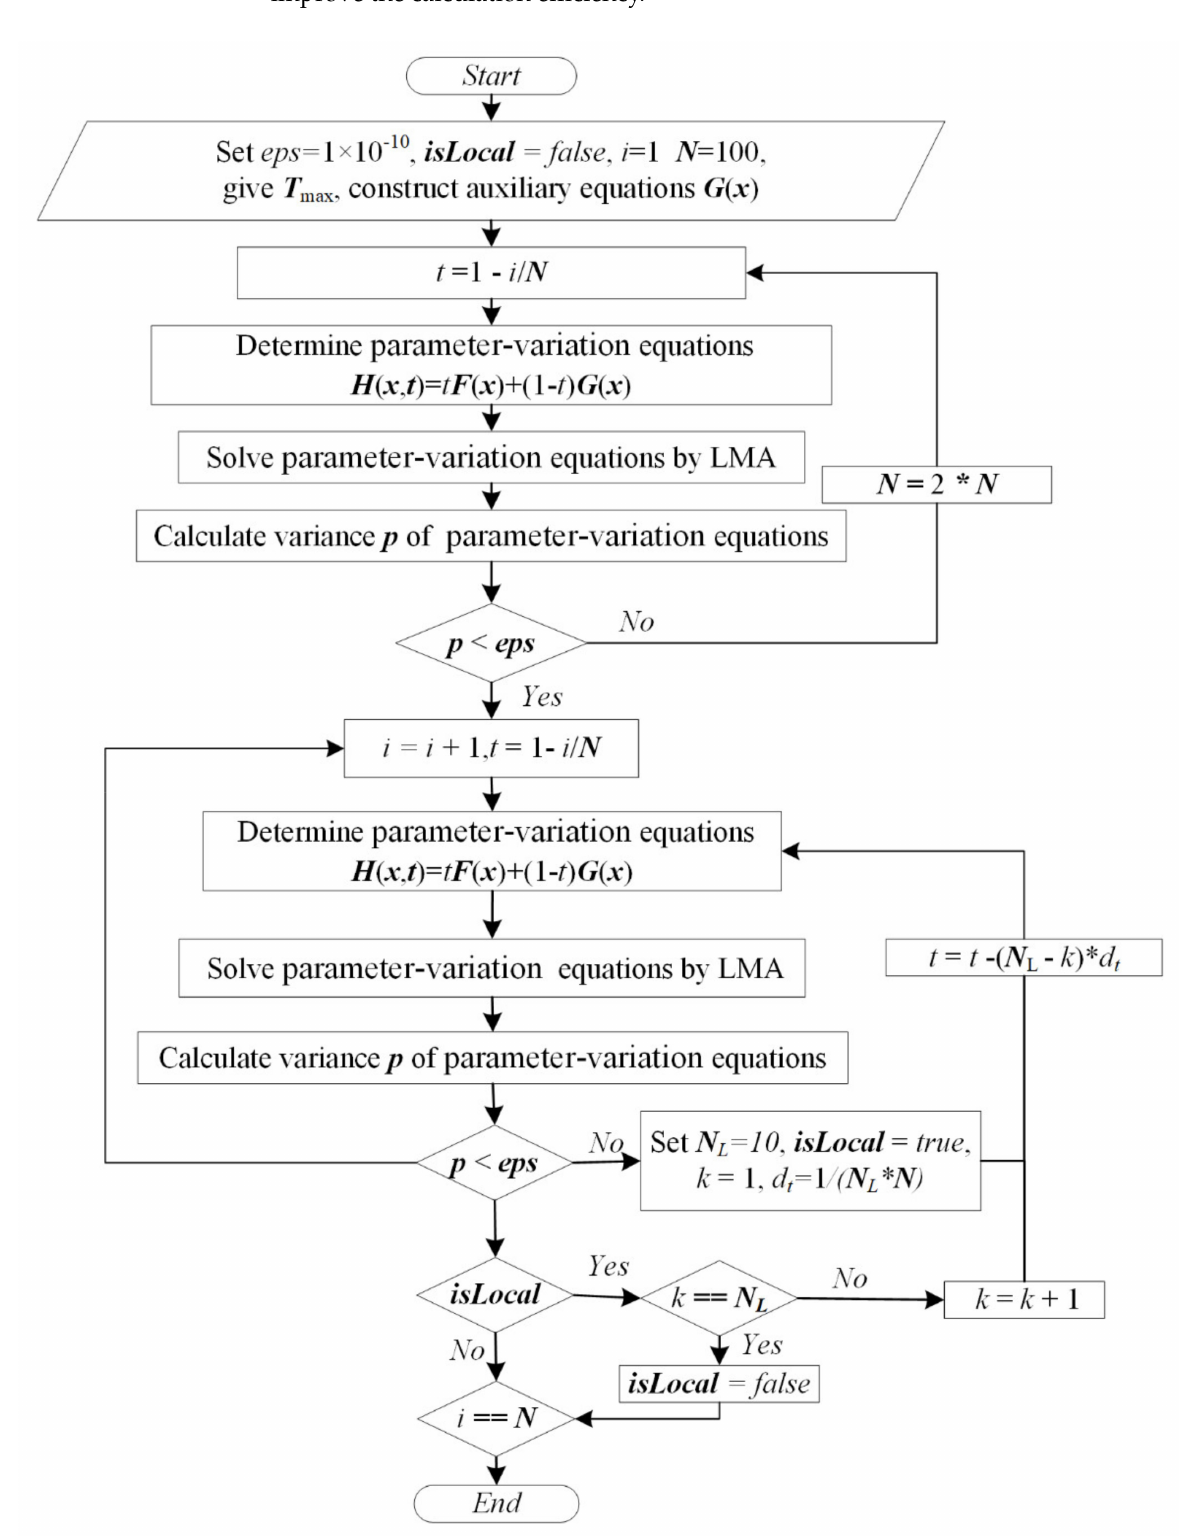
Figure 1. Calculation flow chart of PVM-LMA for solving the plasma